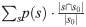

(A) Correlation between length-normalized structural entropy values, as computed by DP and five stochastic context free grammars: grammars G4, G5 and G6 for the ‘Benchmark’ training set, and G6 for ‘Rfam5’ and ‘Mixed80’ training sets (see [24]). Low correlation is shown between length-normalized thermodynamic structural and derivational entropies. For the fixed grammar G6, very high correlation is displayed between length-normalized entropy values for each of the training sets ‘Benchmark’, ‘Rfam5’, ‘Mixed80’ (similar results for fixed grammars G4,G5—data not shown). Although grammars G4 and G5 display a moderately high correlation together, there is low correlation with length-normalized entropy values determined by the grammar G6. Benchmarking set consists of the first sequence in the seed alignment from each family in the database Rfam 11.0 [40]. (B) Scatter plots and correlation between thermodynamic structural entropy and several measures of structural diversity, computed from 960 tRNA sequences in the seed alignment of family RF00005 from from the Rfam 11.0 database [40]. Correlation is computed between the following normalized values: (1) DP: length-normalized thermodynamic structural entropy computed by DP algorithm. (2) Native Contacts: proportion of base pairs in the Rfam consensus structure that appear in the low energy Boltzmann ensemble, defined by ∑sp(s)·|s∩s0||s0|, where s
0 is the Rfam consensus structure. (3) Positional Entropy: average positional entropy, defined by ∑i=1nH2(i)/, where H
2(i) is defined by Eq (5). (4) Expected base pair distance: length-normalized value determined from ∑s
p(s)⋅d
BP(s,s
0), where s
0 is the Rfam consensus structure, which equals ∑1 ≤ i < j ≤ n
I[(i,j) ∉ s
0]⋅p
i,j+I[(i,j) ∈ s
0]⋅(1−p
i,j) where I denotes the indicator function—see [14]. (5) Ensemble defect: length-normalized value determined from n-∑i≠jpi,j*·I[(i,j)∈s0]-∑1≤i≤npi,i*·I[iunpairedins0], where I denotes the indicator function, and pi,j* is defined in Eq (4)—see [50]. (6) Str. Div. (V): Vienna structural diversity, output as ensemble diversity by RNAfold -p[10]. (7) Str. Div. (MH): Morgan-Higgs structural diversity [30], defined in the text. Positional entropy is moderately correlated with DP; ensemble defect and expected base pair distance are highly correlated, and each is moderately correlated with the proportion of native contacts. Structural diversity (Vienna and Morgan-Higgs) are highly correlated with positional entropy, but only (surprisingly) only moderately correlated with conformational entropy DP, in spite of the fact that all these measures concern properties of the ensemble of structures. Ensemble defect, expected base pair distance and expected number of native contacts are all highly correlated; this is unsurprising, since all measures concern the deviation of structures in the ensemble from the minimum free energy structure. Note that positional entropy is poorly correlated with the proportion of native contacts, although Huynen et al. [21] show that base pairs in the MFE structure of 16S rRNA tend to belong to the structure determined by comparative sequence analysis when the nucleotides have low positional entropy.